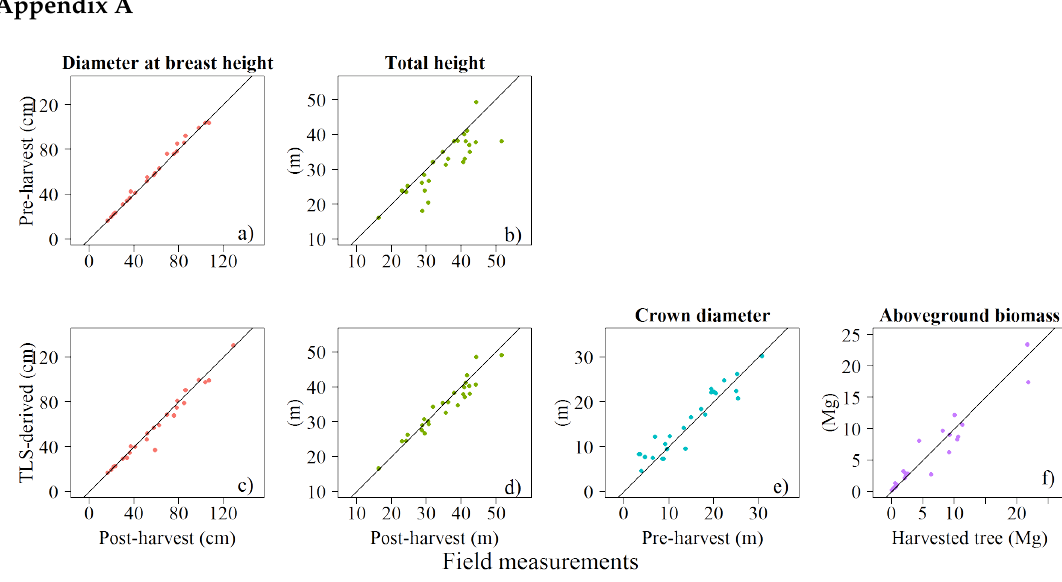
Figure A1. Relationship between pre-harvest against post-harvest values for D ( a ) and H ( b ), TLS-derived against post-harvest values for D ( c ) and H ( d ), TLS-derived against pre-harvest values for CD ( e ), and against harvested tree AGB ( f ), Solid line is 1:1 relationship. Table A1. Summary of AGB estimates from TLS-derived and pantropical allometric models— R 2 , RMSE, CCC, sum of errors (sum, mean, standard deviation (SD)), mean percent error and relative error ( n = 26) separated in small trees (D ≤ 70cm) and large trees (D > 70cm). Models are arranged based on the statistical parameters from the best model to the worst